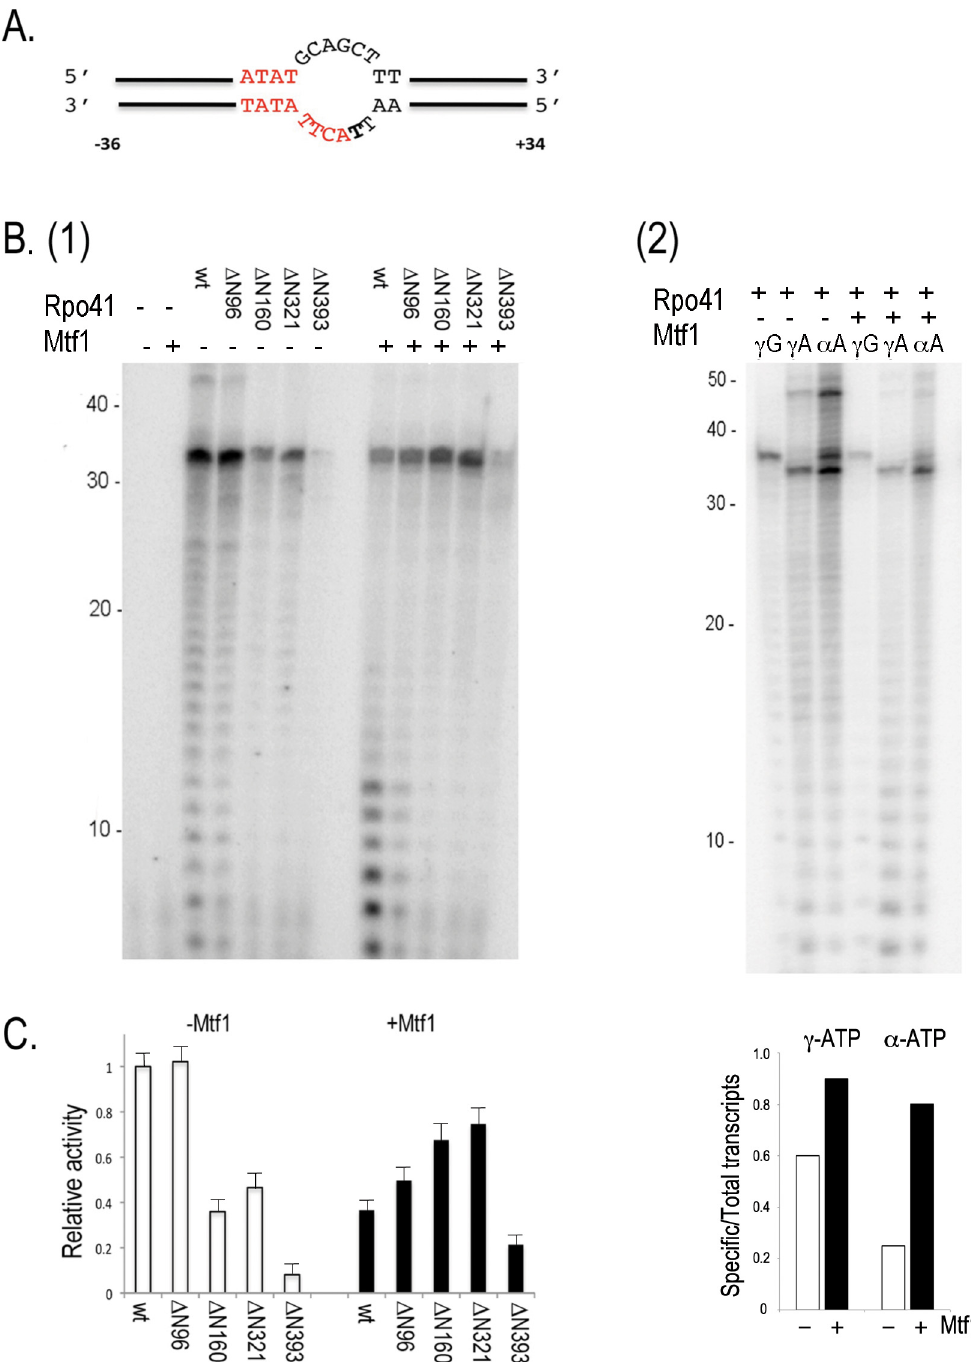
Fig 5. Activities of Rpo41 variants on pre-melted promoter-containing DNA. (A). The duplex DNA template contains a 14S rRNA promoter, with non- complementary sequences from positions-4 to +2. (B) (1) [ γ - 32 P]ATP labeled transcripts on the above template (1 μ M) using Rpo41 (0.5 μ M wild-type or a variant) in the absence or presence of Mtf1 (2.5 μ M) were visualized on a polyacrylamide denaturing gel. (2) Same as (1), except that transcripts are labeled with [ γ - 32 P]ATP, [ γ - 32 P]GTP or [ α - 32 P]ATP. C) The intensities of run-off transcripts in B (1) quantified using Quantity One software.